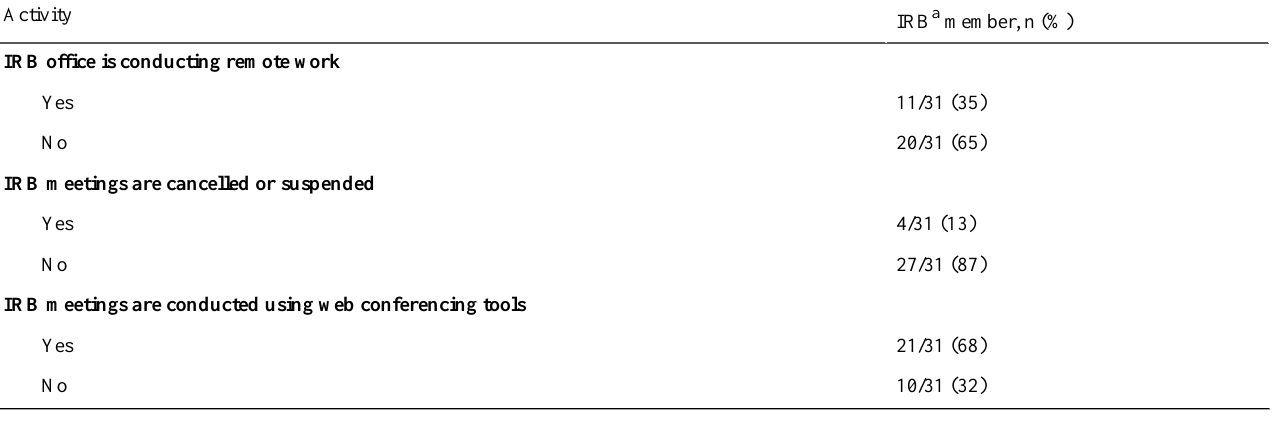
Table 1. Activity and preparation regarding web-based institutional review board meetings in university hospitals during the COVID-19